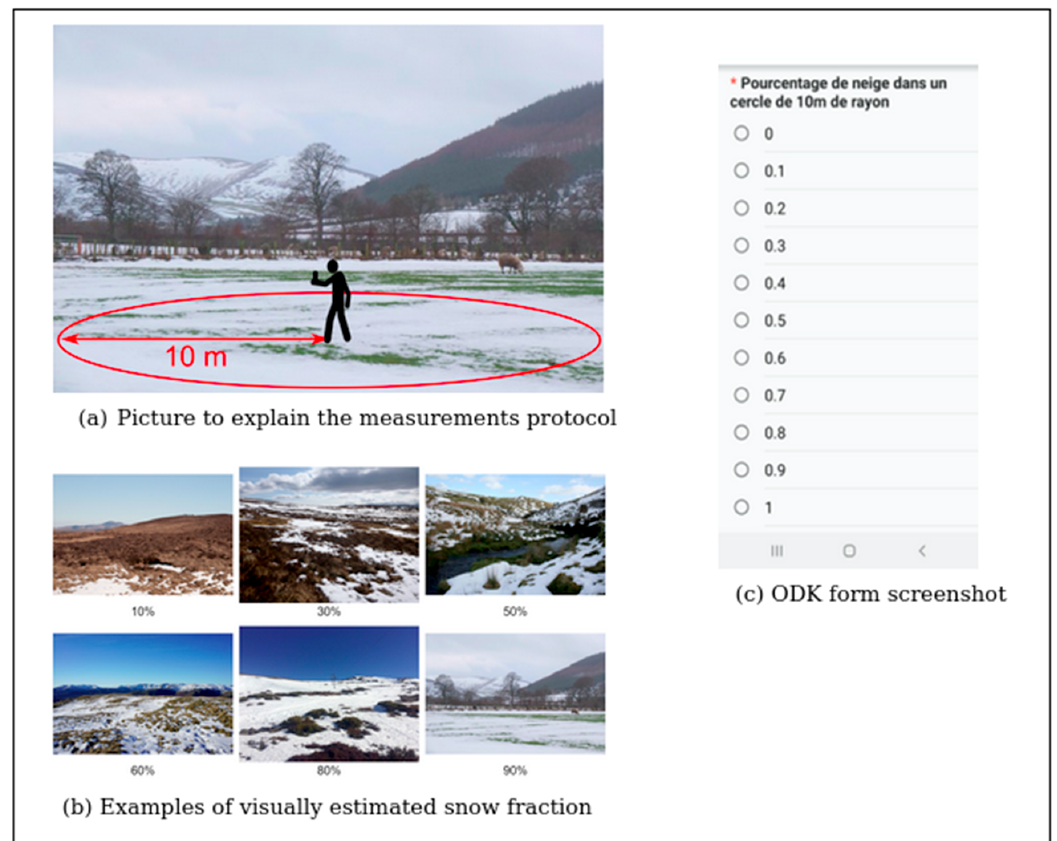
Figure 6. Presentation of the ODK Collect initiative used to collect crowded-sourced snow fraction data.